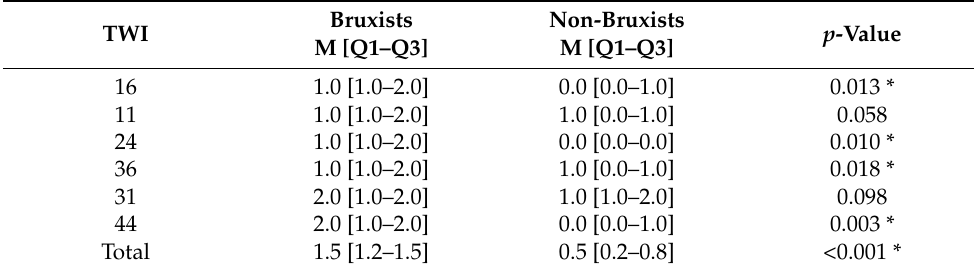
Table 2. Comparison of the Tooth Wear Index between bruxists and